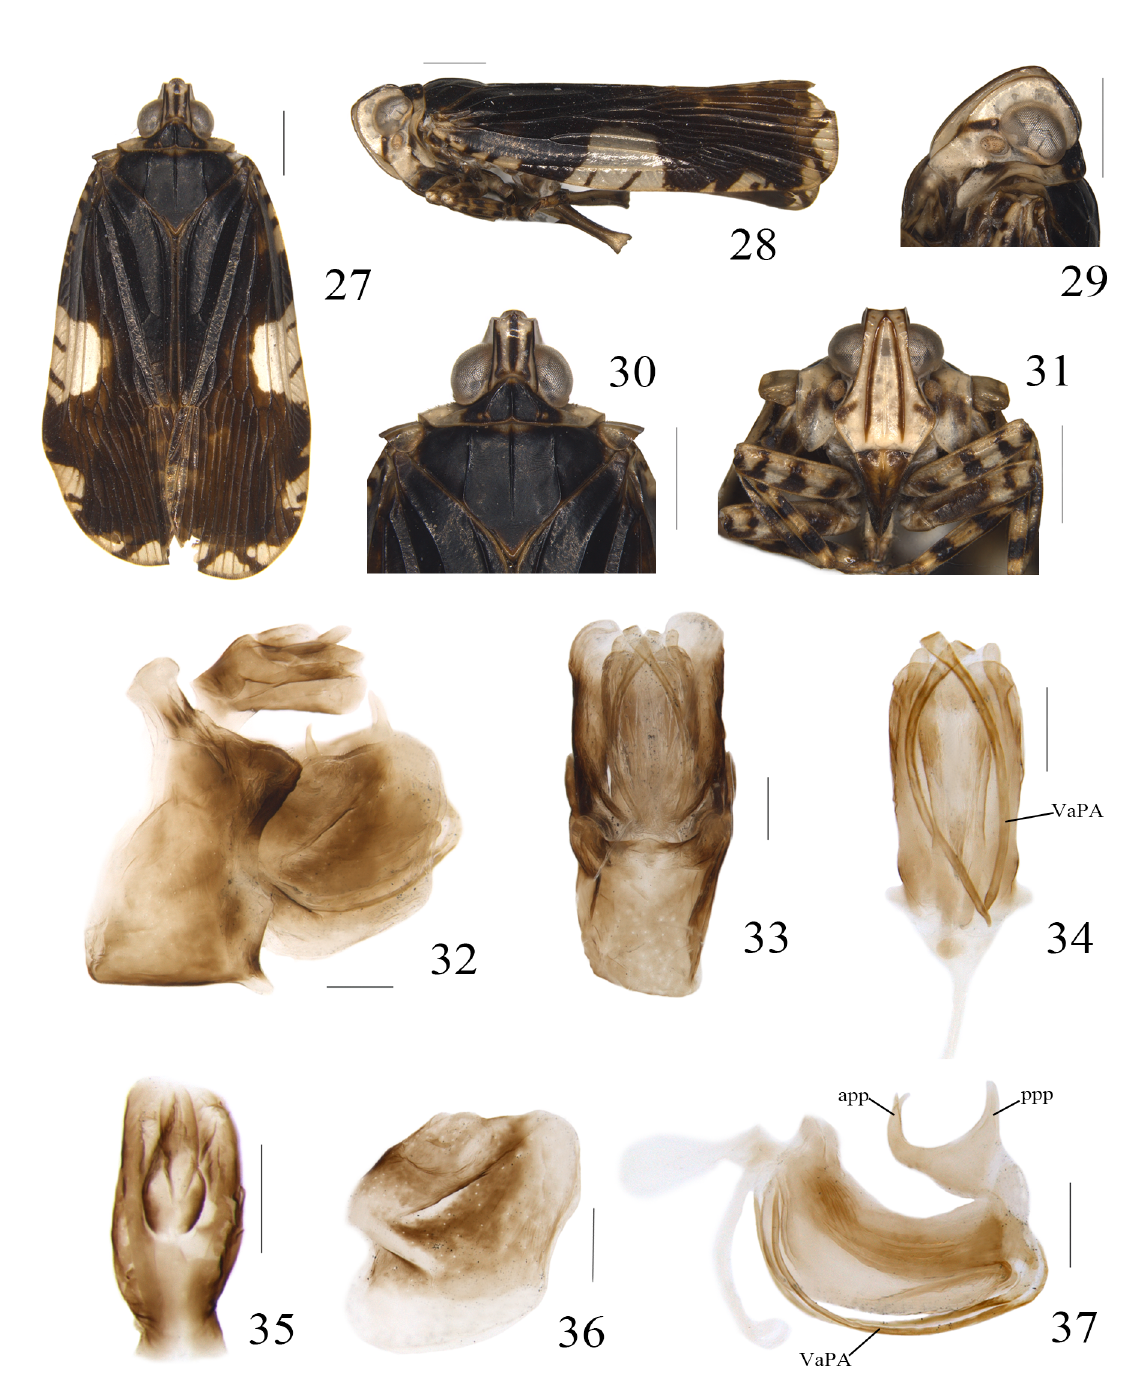
Figs 27–37. Pitambara tricorne Wang & Wang, sp. nov., holotype, ♂. 27 . Habitus, dorsal view. 28 . Habitus, lateral view. 29 . Head, lateral view. 30 . Head and thorax, dorsal view. 31 . Frons and clypeus. 32 . Male terminalia, lateral view. 33 . Male terminalia, ventral view. 34 . Phallic complex, ventral view. 35 . Anal tube, dorsal view. 36 . Gonostylus, lateral view. 37 . Phallic complex and tectiform structure, lateral view. Scale bars: 27–31 = 1 mm; 32–37 = 0.2